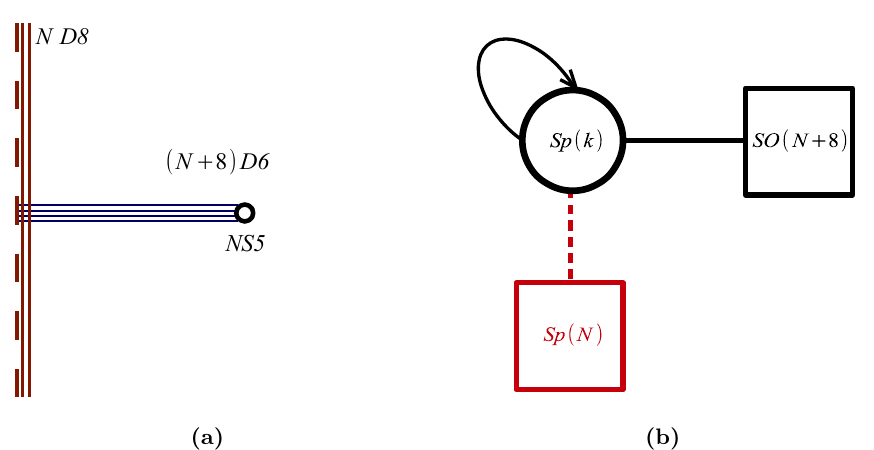
Figure 19. (a): brane construction and (b): 2d (0,4) quiver for k BPS strings of the 6d (1,0) SCFT with ( n; G ) = (4 ; SO(8 + N )). The dashed and continuous edge symbolizes respectively bifundamental Fermi and hypermultiplets, while the gauge node supports an adjoint vector multiplet and a hypermultiplet in the antisymmetric representation of Sp( k ), symbolized by the